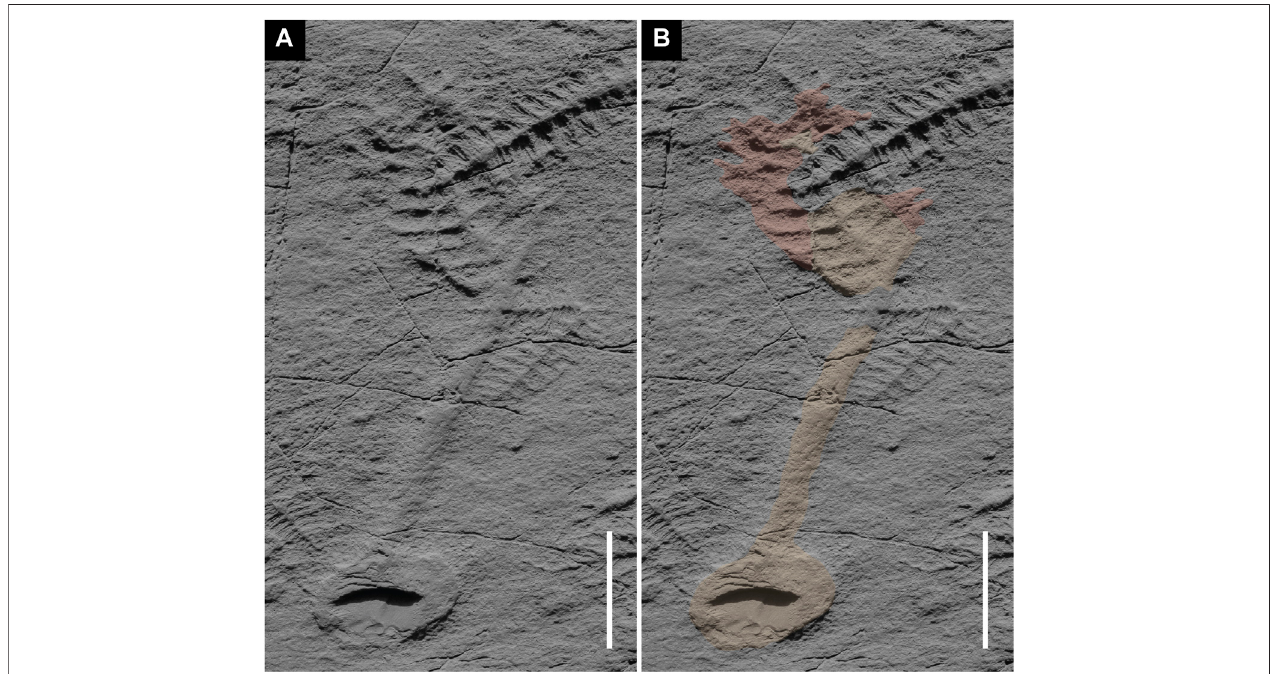
FIGURE 6 | Charniodiscus procerus from the so-called “ Seilacher ’ s Corner ” , upper part of the Mistaken Point Formation ( ‘‘ E ’’ -surface) at Mistaken Point, Newfoundland. (A) cast. (B) Basal disc, stem and fl at basal section of the branches meeting the central axis at ∼ 90 ° in orange; apical section of the branches showing pronounced curvature in red. Scale bars 3 cm. Jesmonite cast of fi eld specimen. Not retrodeformed.